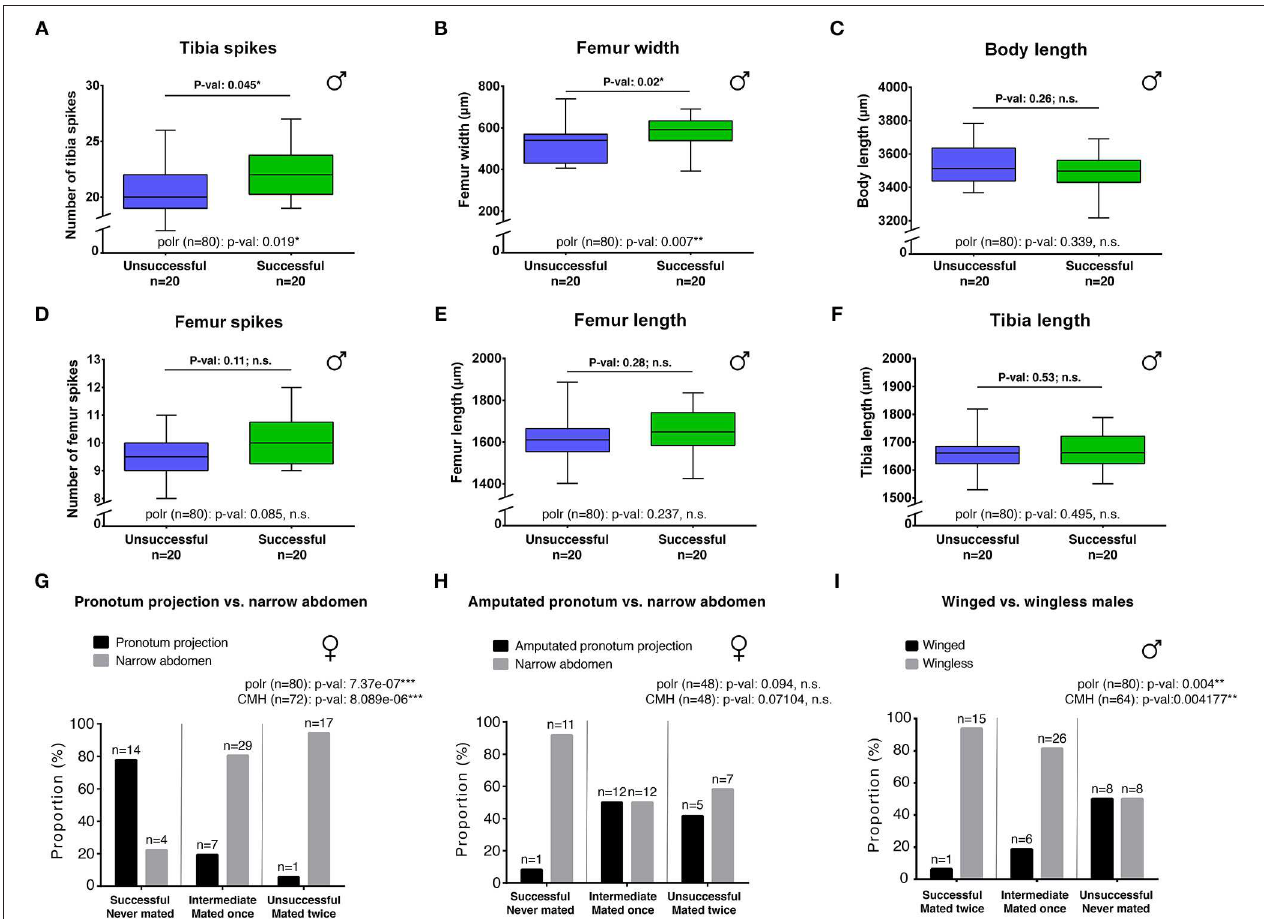
FIGURE 3 | Morphological comparisons and effect on mating performance. Successful males have significantly higher number of tibia spikes (A) and larger femur (B) compared to unsuccessful males. There are no significant differences between the two classes of males for body length (C) , number of femur spikes (D) , femur length (E) and tibia length (F) . Student t -tests were performed for all comparisons except for the number of femur spikes (Wilcoxon test). (G–I) show the distribution of the different morphs ecotype in the different classes of performance with the associated results of Cochran-Mantel-Haenszel Chi-square test. Significant p -values indicate association between the morph ecotype and the performance. Females with pronotum projection are more efficient than females with narrow abdomen in rejecting males (G) . Females with amputated pronotum projection lost their ability to efficiently reject males (H) . Wingless males are more efficient than winged males in mating (I) . A proportional odds logistic regression analysis (polr) for the different phenotypic variables is indicated in all graphs. Significant p -values indicate association between the phenotypic trait measured and success in mating efficiency for males and male rejection for females. n indicates sample